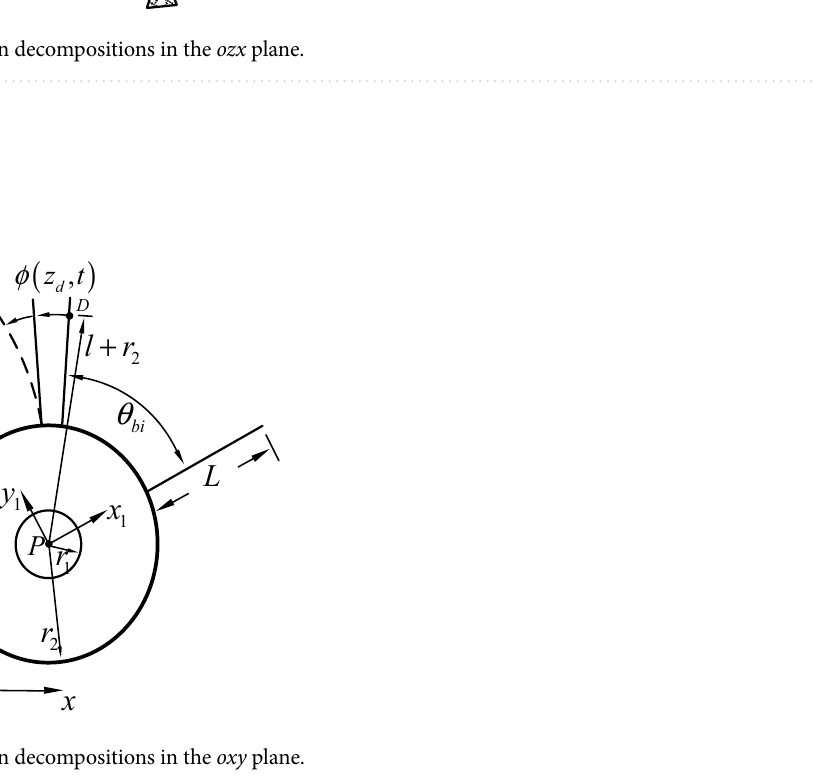
Figure 3. Motion decompositions in the oxy